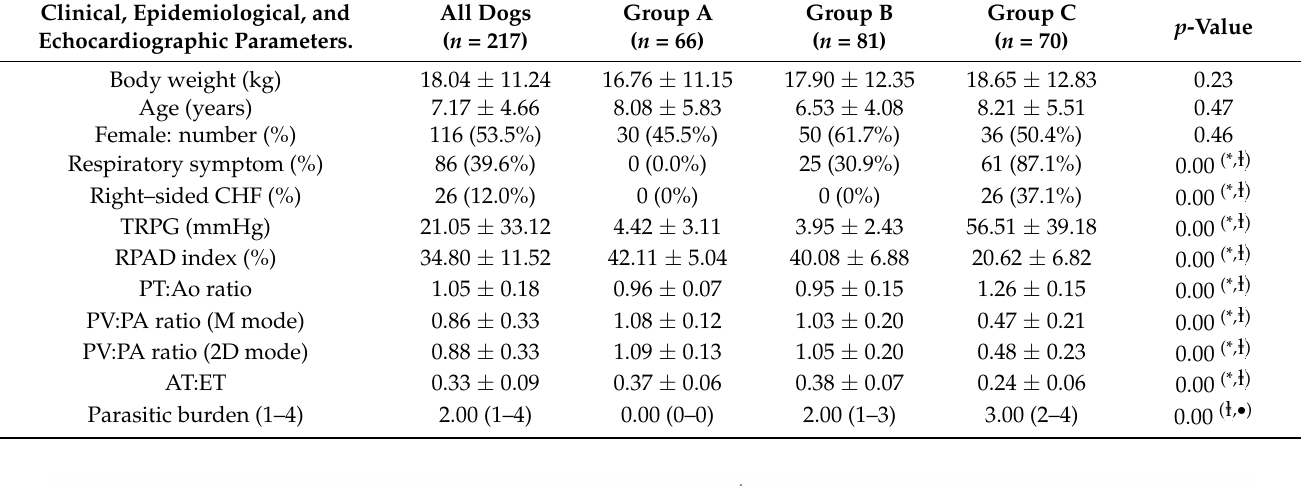
Table 1. Clinical, epidemiological, and echocardiographic parameters of the studied dogs (group A: healthy dogs, group B: heartworm-infected dogs and absence of PH, group C: heartworm-infected dogs with PH). Data represent median and standard deviation (min–max) unless otherwise stated: RPAD index, right pulmonary artery distensibility index; TRPG, peak tricuspid regurgitation systolic pressure gradient; PT, pulmonary trunk; Ao, aorta; PV:PA pulmonary vein to pulmonary artery ratio; M mode, time–motion mode; 2D mode, two-dimensional mode; AT:ET, right acceleration time to ejection time ratio. Results for female, respiratory symptoms, and right-sided CHF are expressed as n (%). Results for parasite burden are expressed as median (range). Significant differences were found when p -value < 0.01. (*): significant differences observed between groups C and B; ( AT:ET